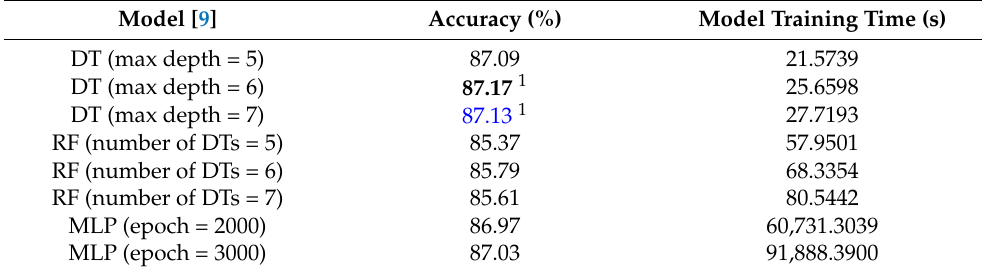
Table 5. Performance results of the ML models for TT_V